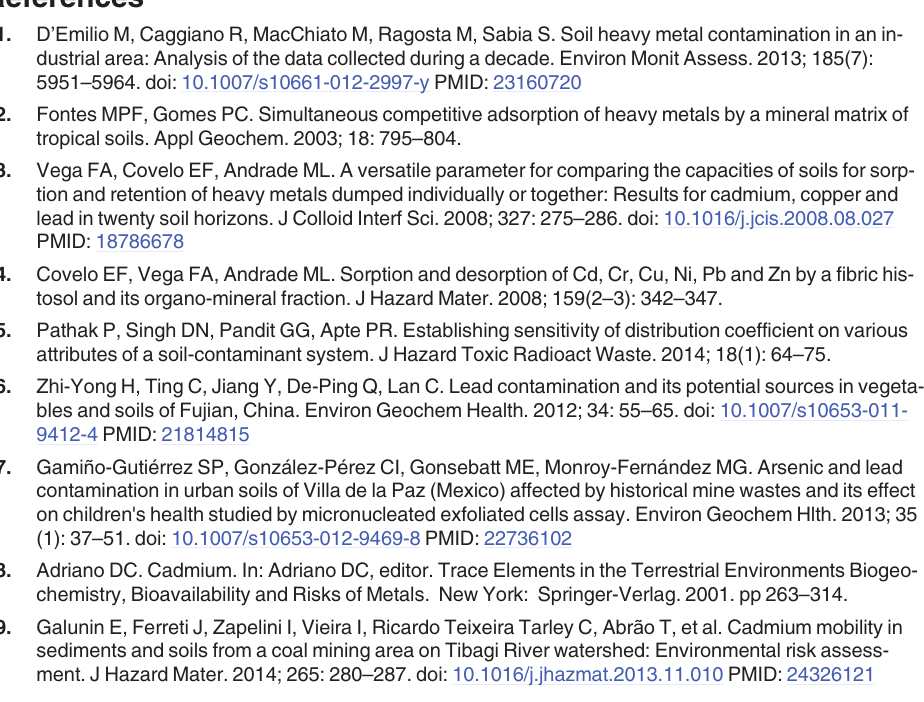
Fig 7. (a): FE-SEM image with Cd 2+ and Pb 2+ fixed on Fe amorphous oxides associated with clays (DU.Bw) and typical EDS of clay and Fe oxides containing Cd and Pb; (b) FE-SEM image of Pb 2+ sorbed on